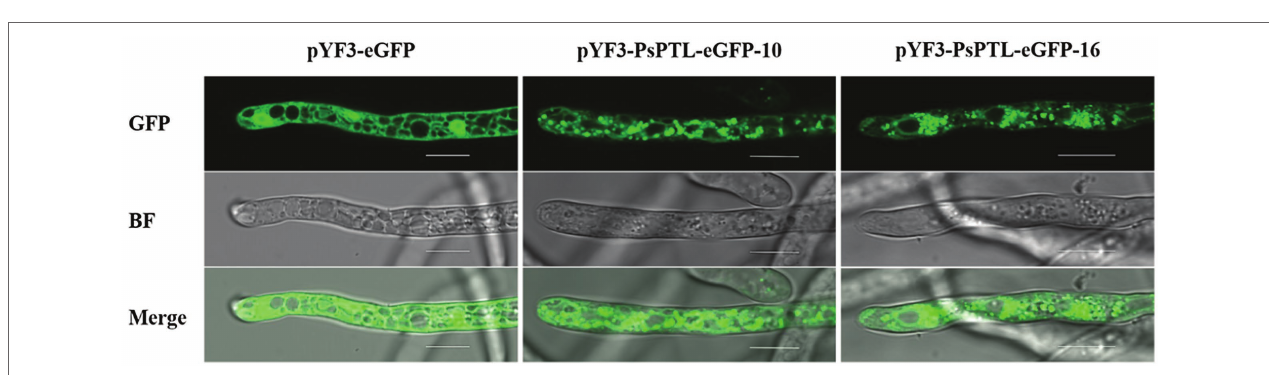
FIGURE 3 | Subcellular localization of Patched-like (PTL) protein in P. sojae hyphae. The hyphae of transformants expressing pYF3-PsPTL-eGFP or pYF3-eGFP, respectively, were observed in green fluorescent protein (GFP) field (top), bright field (BF, middle), and merged field (bottom). Bars represent 10 μ